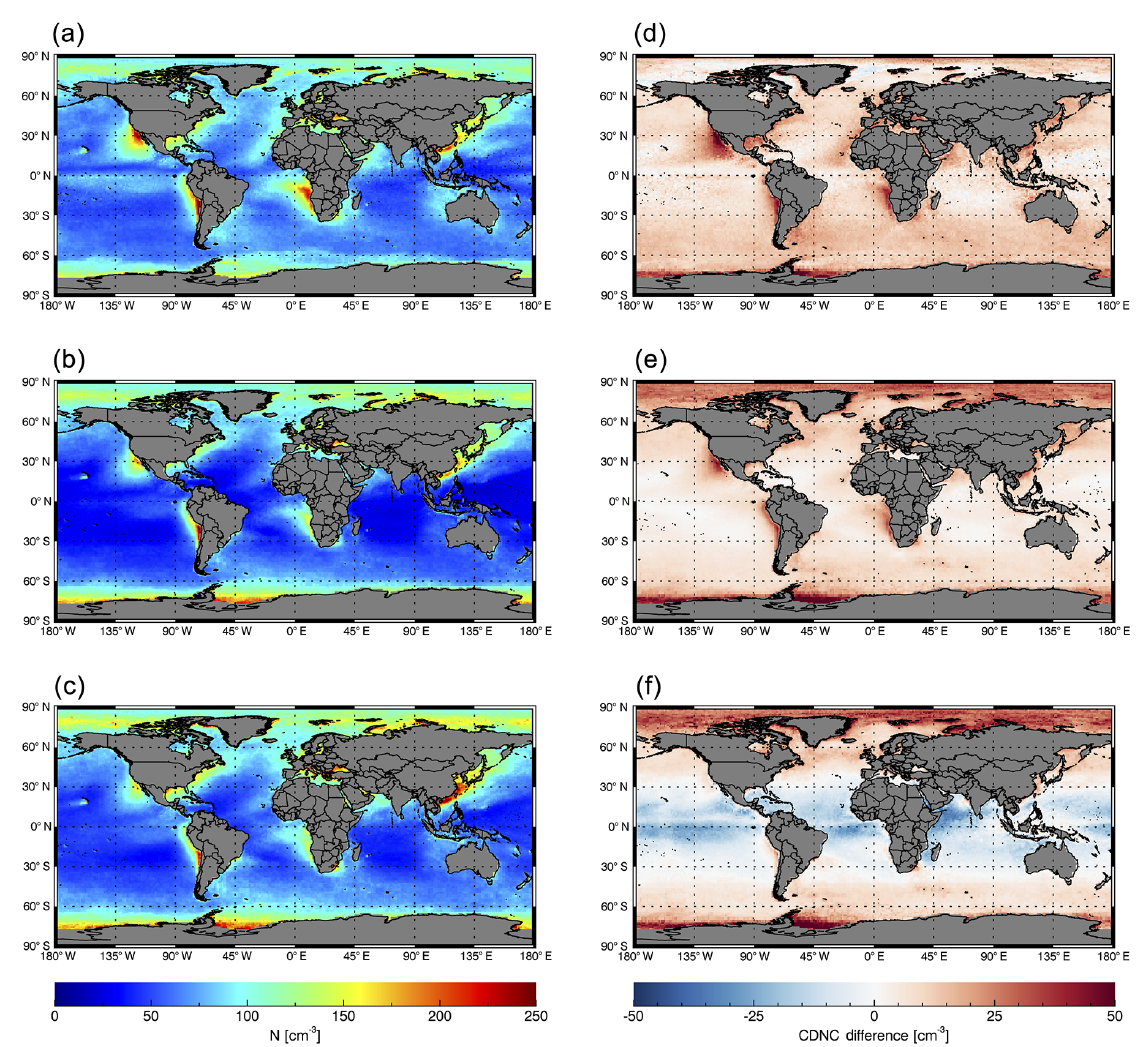
Figure 3. Mean annual Collection 6 cloud droplet number concentration for year 2008 for the (a) 1.6µm, (b) 2.1µm, and (c) 3.7µm channels and C6–C5.1 CDNC differences for the (d) 1.6µm, (e) 2.1µm, and (f) 3.7µm